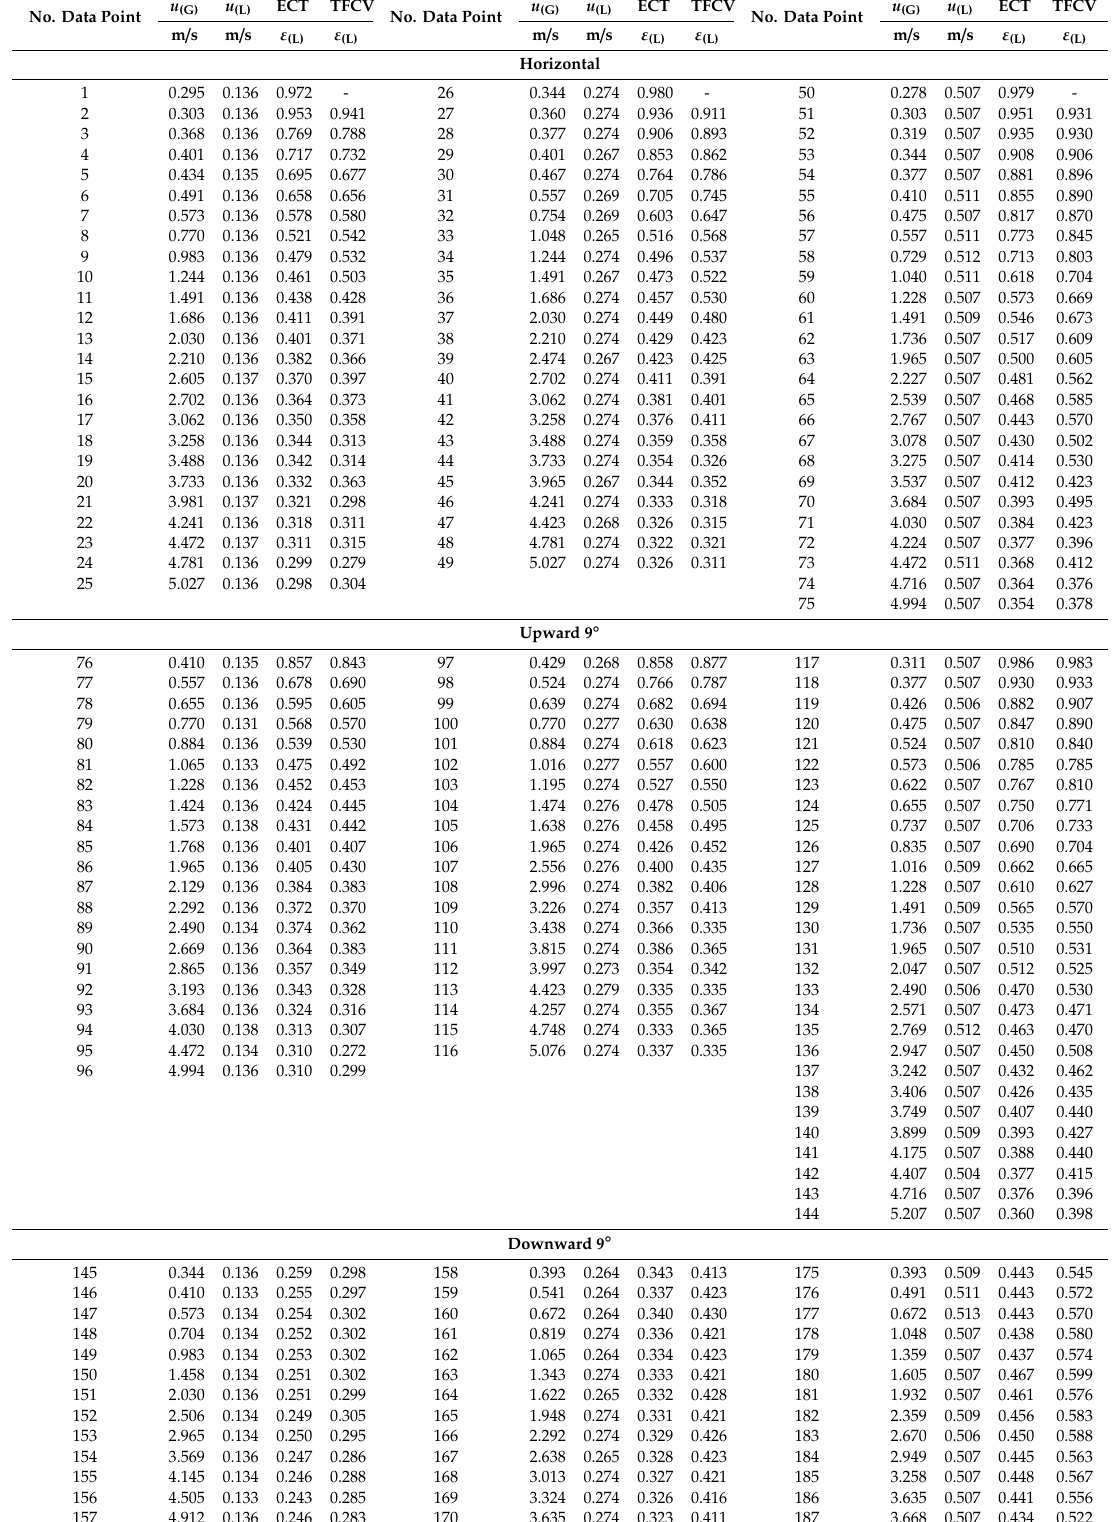
Table A1. Examples of experimental operating conditions and ε (L) from ECT and two fast closing valve (TFCV)